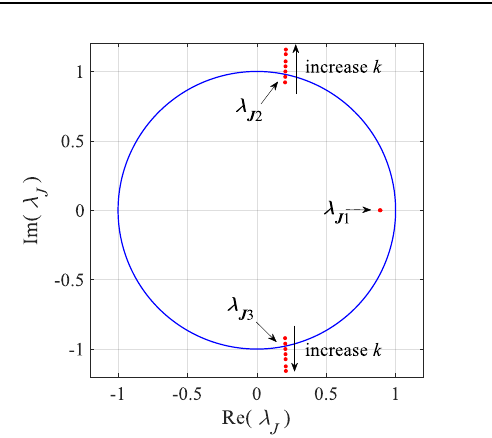
Figure 7. The loci of the Floquet multipliers under the conventional one-step delay control.